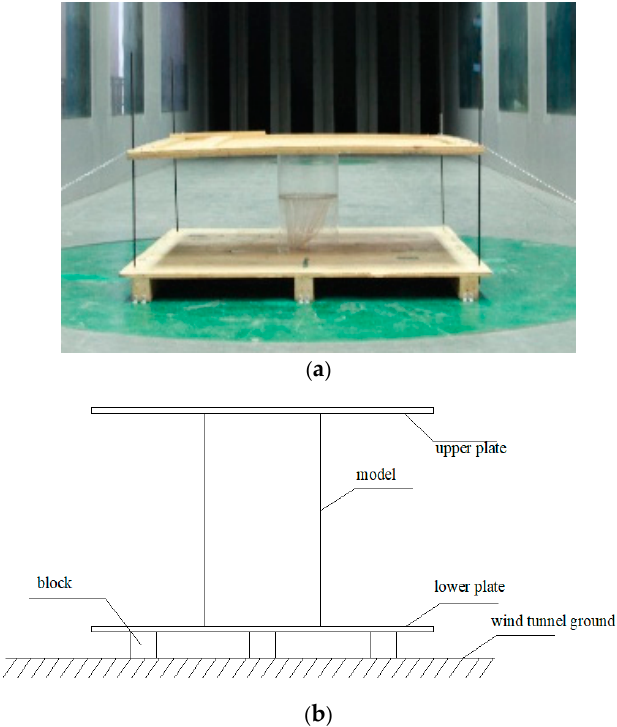
Figure 1. Layout of testing model. ( a ) Testing model in the wind tunnel; ( b ) the drawing of the testing model.